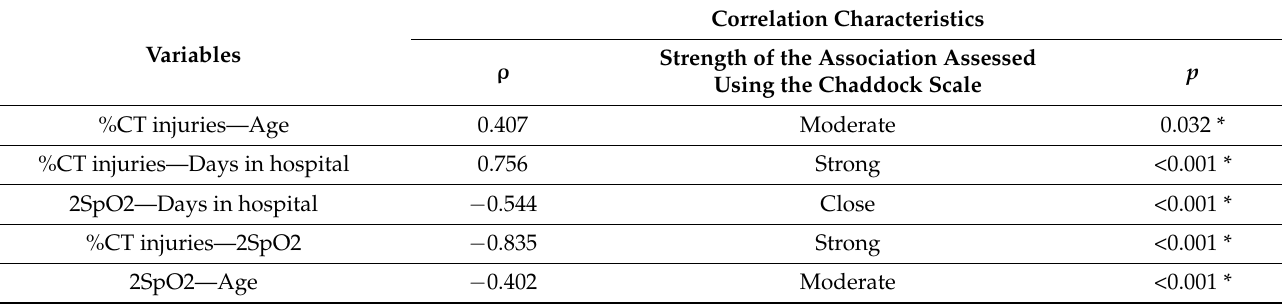
Table 4. Results of the correlation